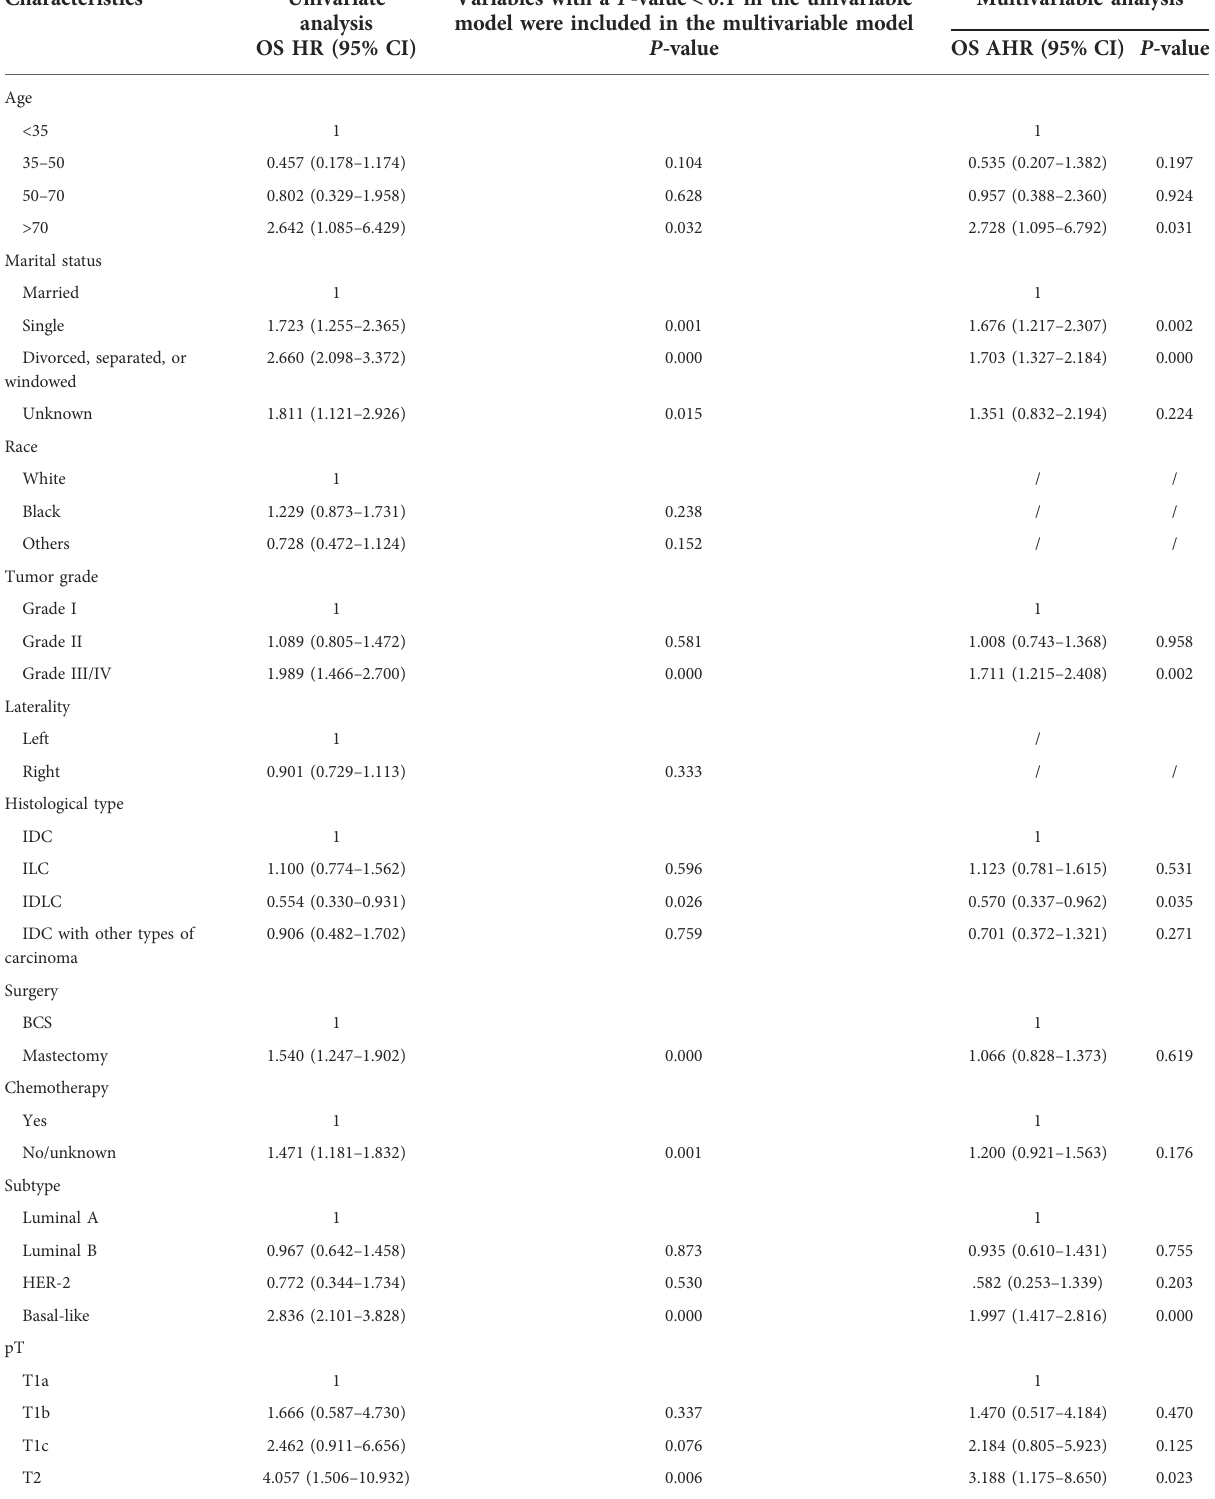
TABLE 2 Univariate and multivariate Cox analysis of overall survival in patients who had one or two sentinel lymph node micrometastases and underwent sentinel lymph node biopsy